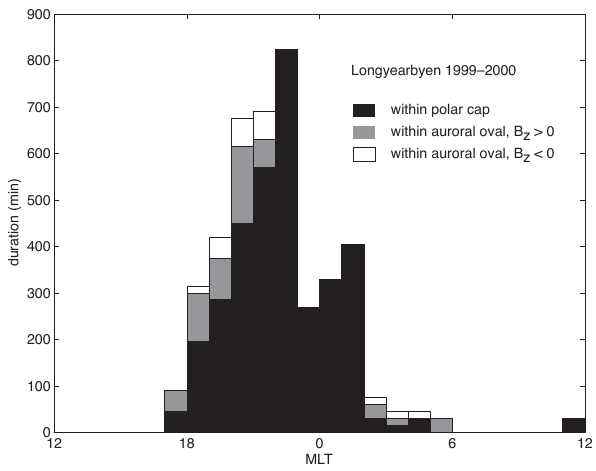
Fig. 1. Total time of Es occurrence at Longyearbyen as a function of MLT at times when the location of the auroral oval was determined by the DMSP satellites. Black columns indicate observations with Longyearbyen inside the polar cap and the other columns indicate those with Longyearbyen in the auroral oval; grey and white during the northward and southward IMF,